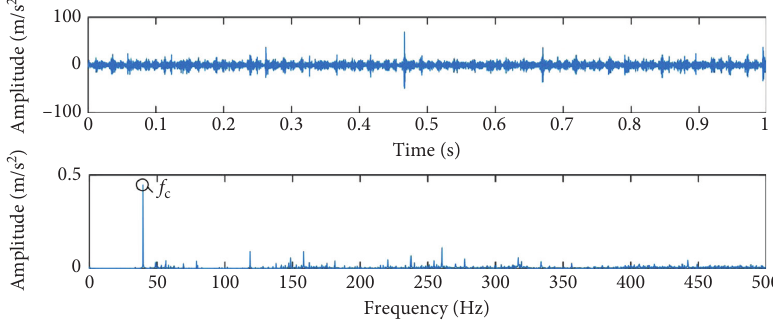
Figure 13: Original vibration signal.